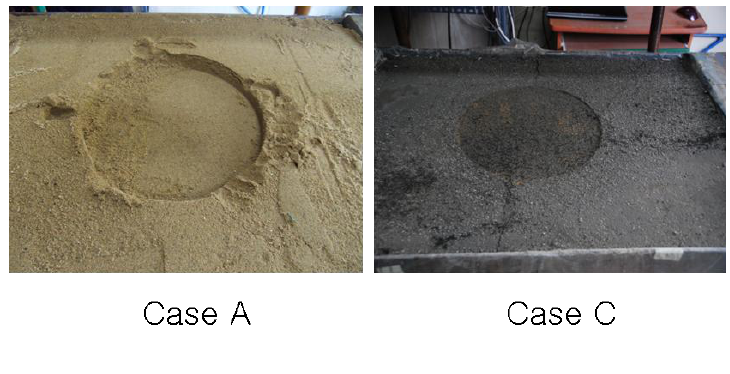
Figure 13. Settlement shape of the